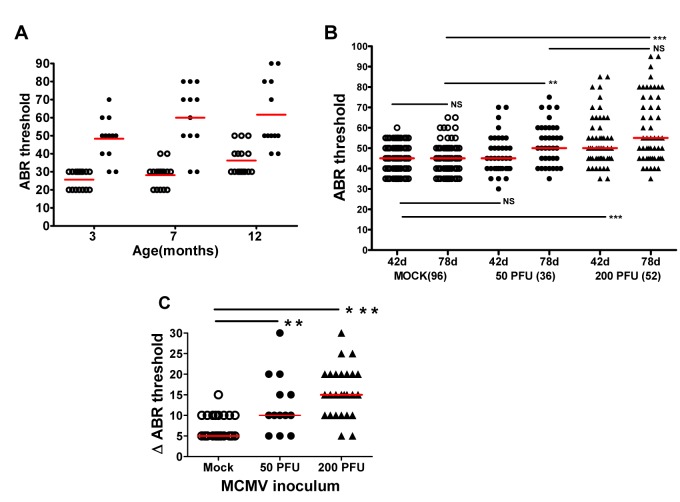
Progressive hearing loss and virus inoculum effect on progression of hearing loss in MCMV infected mice.
(A) MCMV infected mice exhibit increased ABR threshold as function of age. Newborn mice infected with uncloned Smith MCMV(●; n = 12) or mock infected (○; n = 15) were tested at approximately 3,7, and 12 months and ABR thresholds determined. Note increasing mean ABR threshold in infected mice at 7 months of age and increase in ABR threshold for both infected and mock infected groups of mice at 12 months of age. At each time point the mean ABR thresholds of mock vs. infected mice were significantly different (p<0.001 two-way Anova with Bonferroni post-test correction). (B) Dose dependence of progressive hearing loss and delayed onset of hearing loss. Newborn mice were inoculated with recombinant, BAC cloned MCMV(50PFU ●; 200PFU ▲) or mock uninfected (○) and tested for auditory function at PNd42 or PNd78. Each symbol represents one ear tested (n = 96 mock, n = 36(50PFU), n = 52(200PFU)). Note the increase in median ABR threshold in mice given 50 PFU between PNd42 and PNd78 as compared to mock infected animals. (**) indicates significant differences (p<0.01) between groups with increase in ABR thresholds as determined by Kruskal-Wallis test of medians with Dunn post-test correction. (C) Magnitude of ABR thresholds in cochlea with progression of hearing loss. The change (dB) in individual cochlea exhibiting an increase in ABR threshold between d42 and d78 (Δ ABR threshold) was plotted for each group and medians compared. Number of cochlea with progression that were analyzed were (mock = 27; 50PFU = 13; 200PFU = 26). Statistically significant differences between median Δ ABR threshold of mock vs 50PFU, (p<0.01) and mock vs. 200PFU (p<0.001) by Kruskal-Wallis test of medians with Dunn post-test correction.